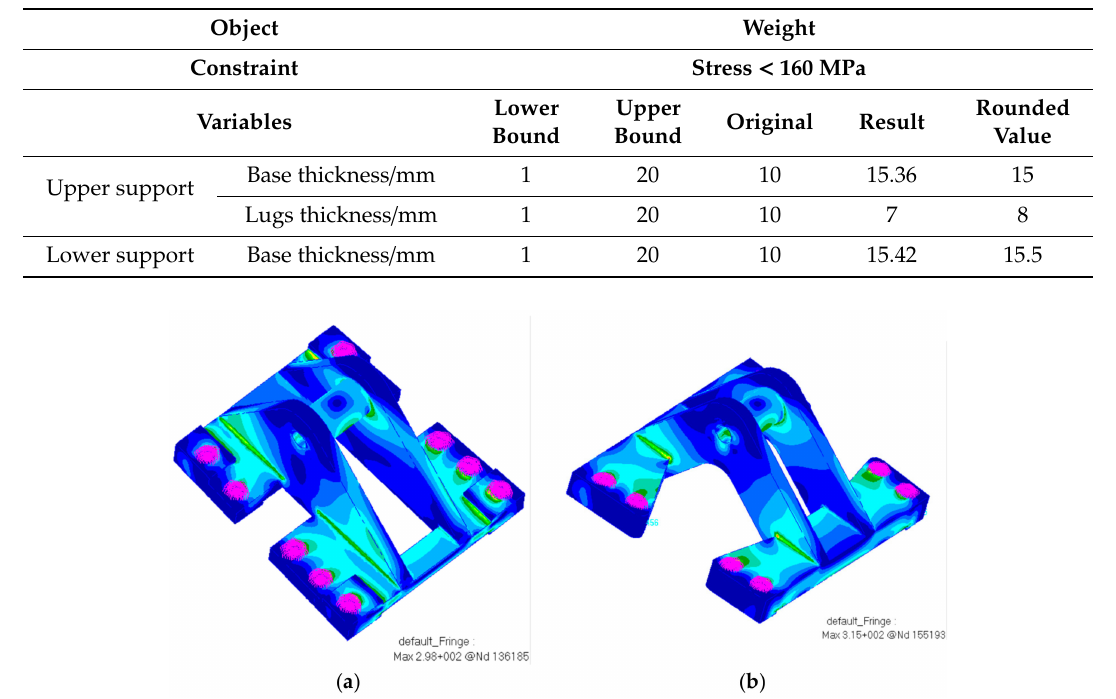
Figure 12. Final supports structure: ( a ) upper support; ( b ) lower support.